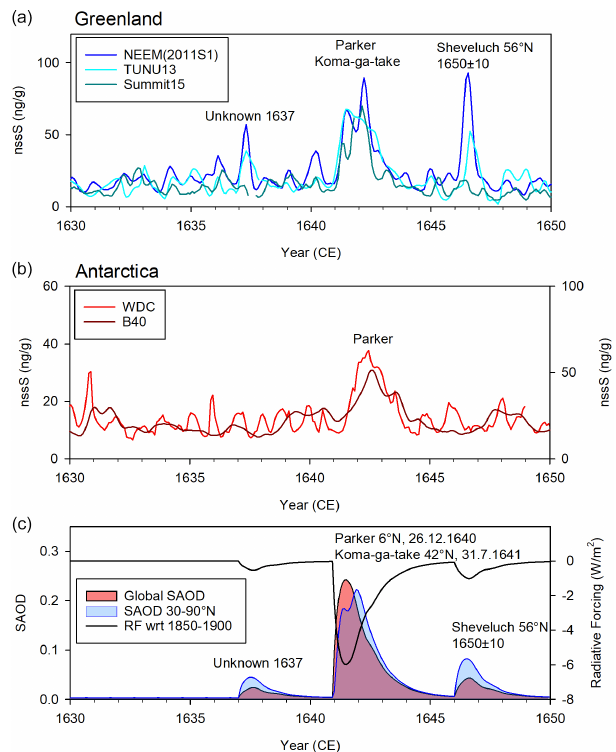
Figure 1. Monthly resolution non-sea-salt sulfur records from ice cores in (a) Greenland and (b) Antarctica, with (c) stratospheric aerosol optical depth (SAOD) and estimated radiative forcing (RF) between 1630 and 1650 (data: Toohey and Sigl,